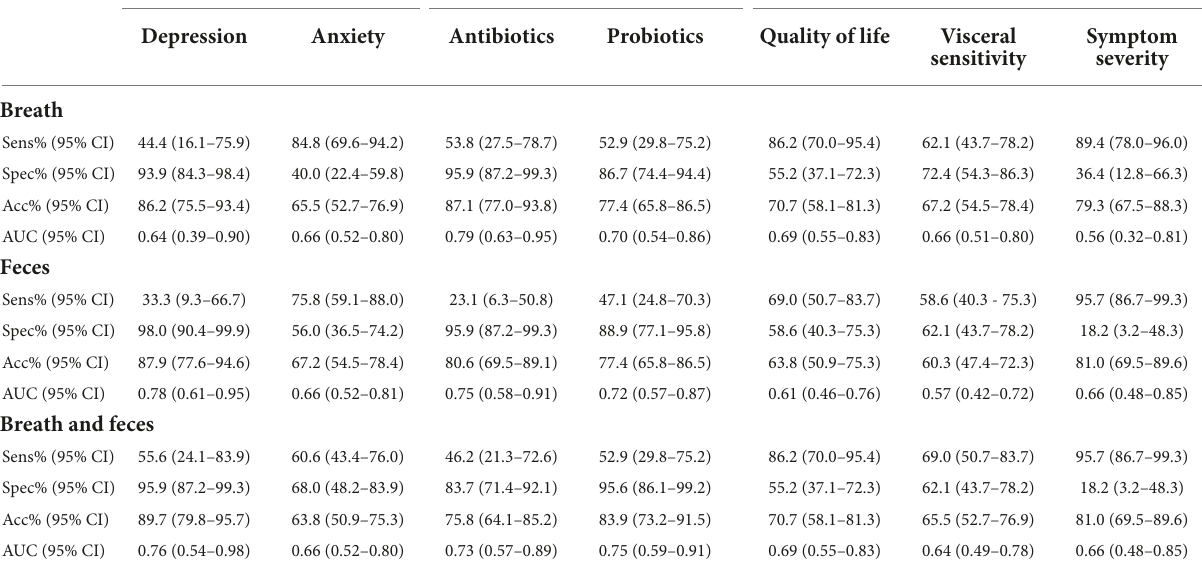
TABLE 5 Differentiating models based on clinical characteristics in